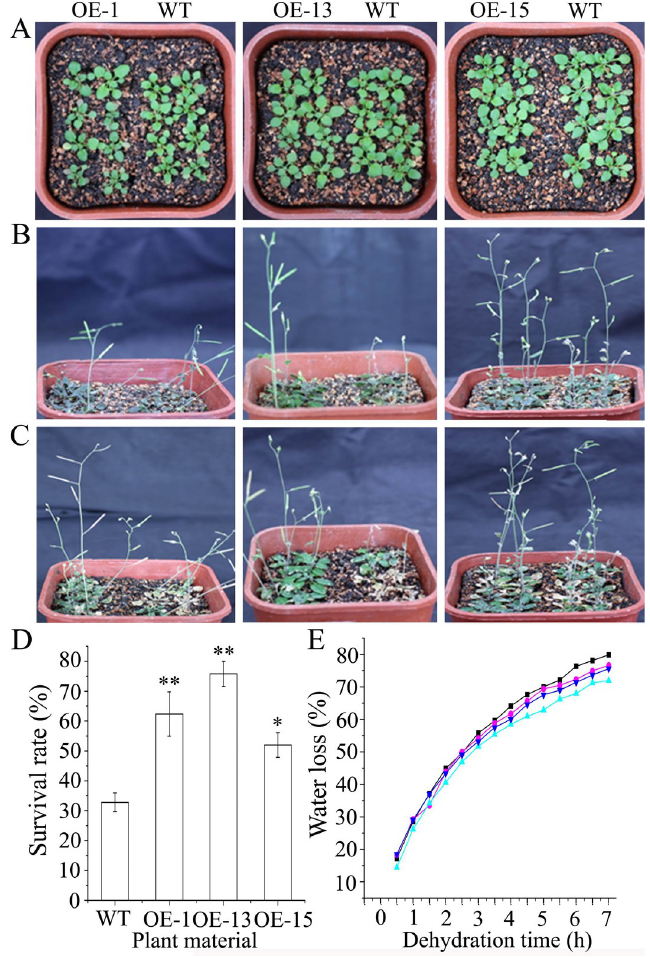
Fig 5. Constitutive expression of AmDREB3 enhanced drought tolerance of transgenic Arabidopsis at the seedling stage. Ten-day-old seedlings were unwatered for 17 d and then re-watered. (A and B) Seedlings and plants before and 17 d after the suspended watering, respectively. (C and D) Plant phenotypes and survival rates after 7 d of re-watering. (E) Water loss of the detached shoots during a 7-h period. Shoots were weighed at 0.5 h intervals. Water loss is represented as the percentage of initial fresh weight (0 h) at each time point. Data are presented as means. Asterisk and double asterisks indicate significant differences of transgenic lines (OE-1, OE-13, and OE-15) compared to wild-type (WT) at p < 0.05 and < 0.01,